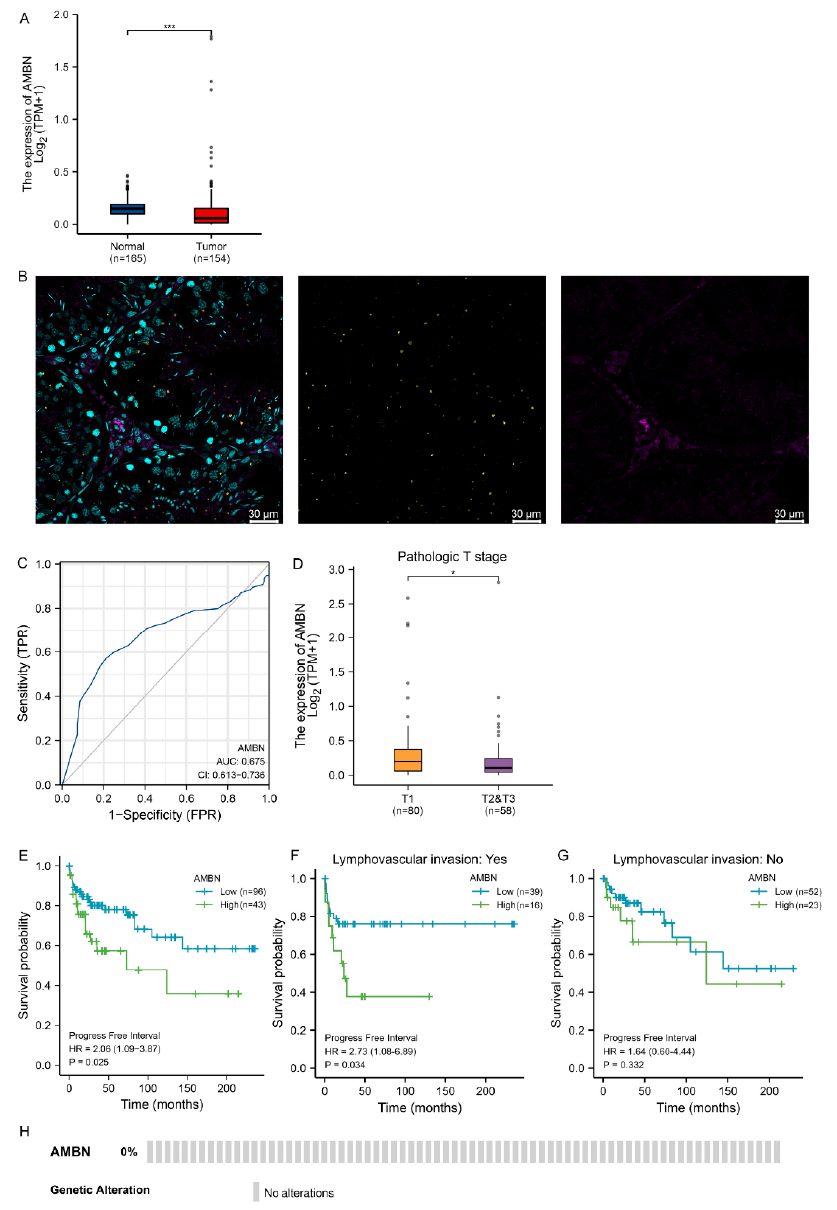
Figure 1. Low mRNA expression of AMBN in TGCT and its clinical implication. ( A ) Distribution of AMBN expression in normal testis and TGCT. ( B ) AMBN expression in rat normal testicular tissue (40 × , anti-AMBN (yellow), anti-vimentin (magenta) and DRAQ5 (cyan) to label the nuclei.) ( C ) Receiver operating characteristic (ROC) curve of AMBN in TGCT ( D ) AMBN mRNA expression in different TGCT stages ( E – G ) Kaplan-Meier survival curves were used to compare the difference in progress free interval (PFI) between low and high mRNA expression of AMBN under different conditions ( H ) OncoPrint plot showing deletion mutations in AMBN gene in TGCT. (*, p < 0.05; **, p < 0.01; ***, p < 0.001).